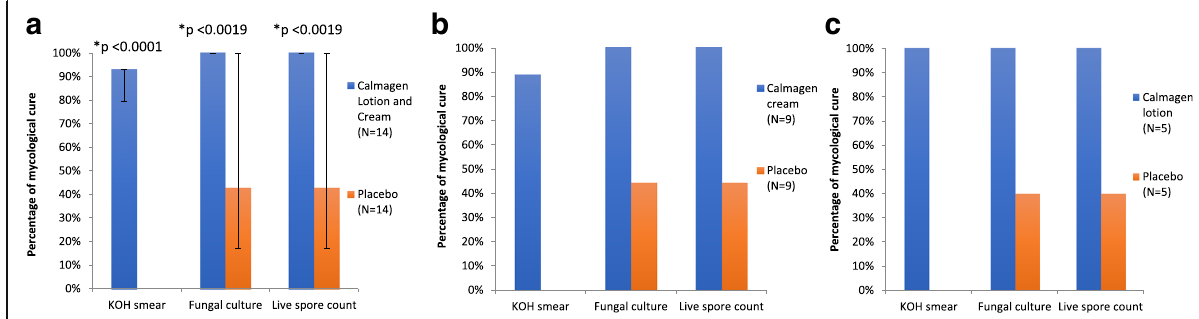
Fig. 2 Calmagen® lotion and cream met primary endpoint: mycological cure based on KOH smear, fungal culture and live spore count. a Combined results on Calmagen® cream and lotion; b Calmagen® cream sub-group results; c Calmagen® lotion sub-group results; p-value; *: statistically significant; N: Number of subjects; KOH:Potassium hydroxide; |-|: confidence interval